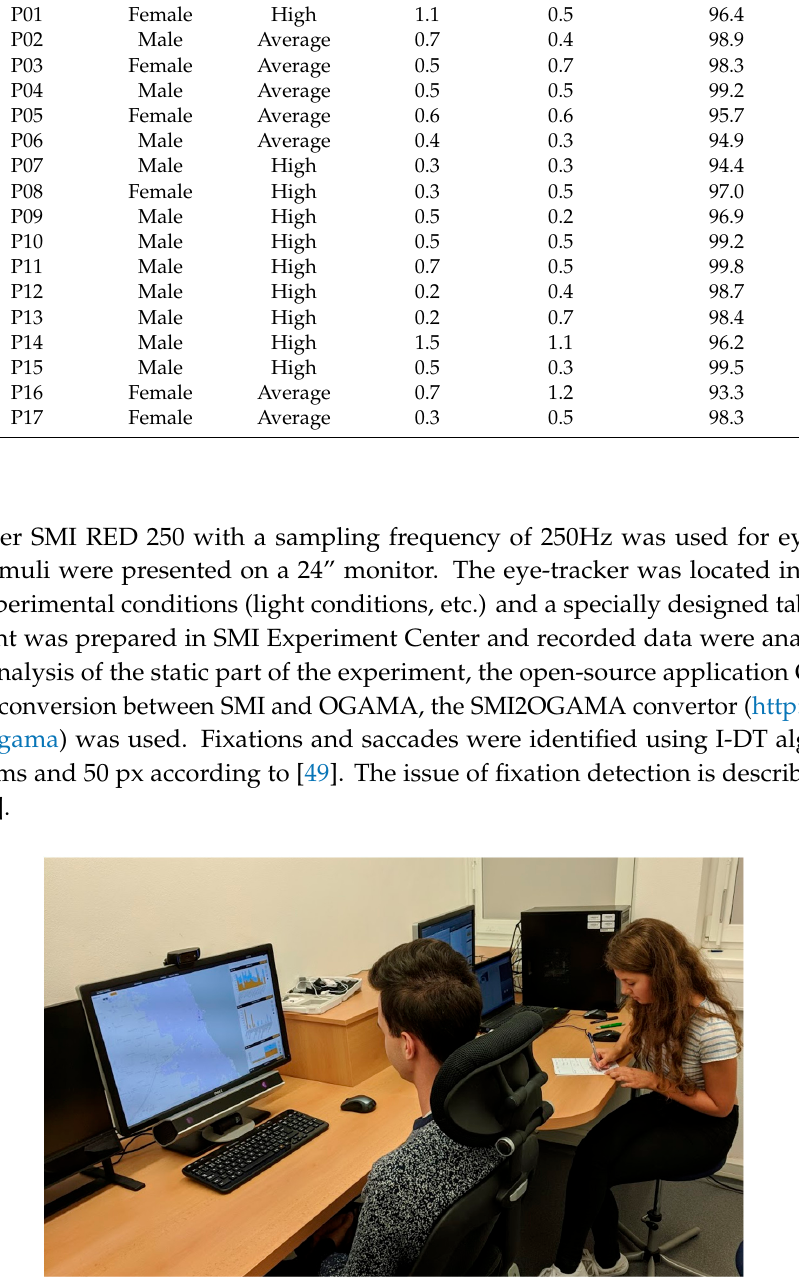
Figure 3. Testing in the eye-tracking laboratory.